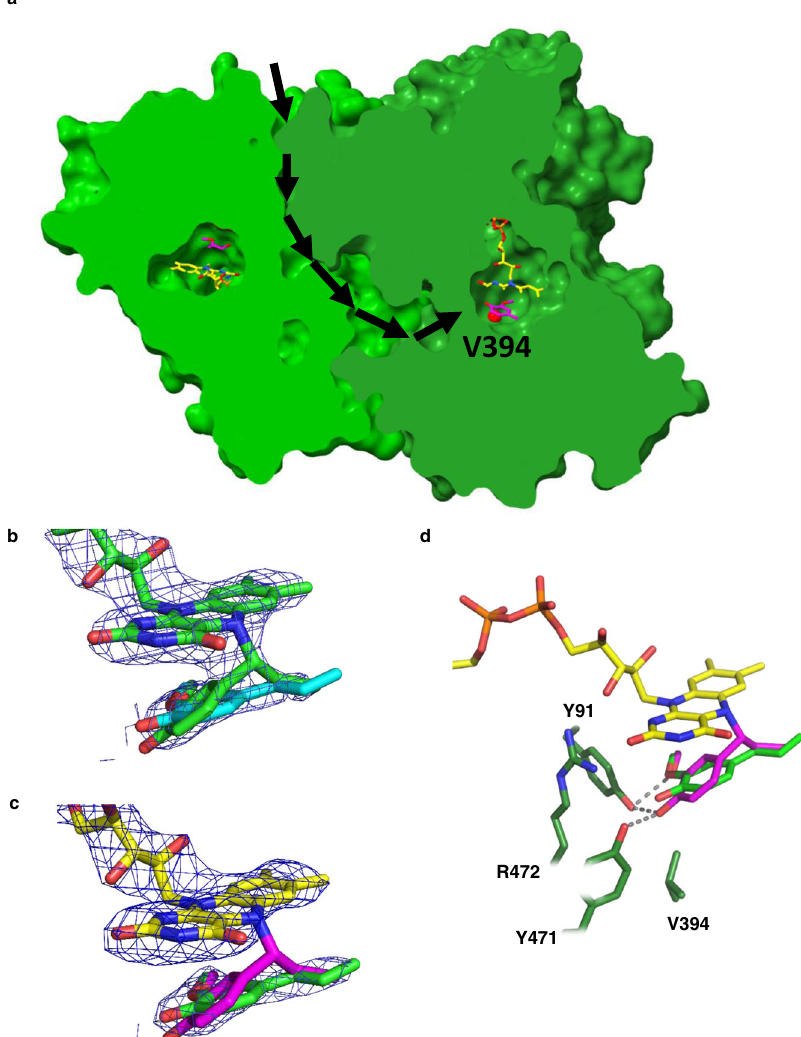
Fig. 5 | Structural features of S394V-EUGO5X. a Position of V394 in the cavity, showingaslicedviewofS394V-EUGO5X.ThemutatedV394,shownasaredsphere, is in close contact with a deep passageway buried between the two chains of the dimer. b , c Detailed views of the electron densitiesof4- n -propylguaiacol bound to twoS394V-EUGO5Xsubunits. b unbiased2Fo-Fcelectrondensitymapshowingthe presence of a stretch of electron density extending from the fl avin N5 atom and suggesting the presence of a covalent bond between the fl avin and 4- n -pro- pylguaiacol in subunit B. c unbiased 2Fo-Fc electron density map of a non- covalentlybound ligandobservedinchainA.Themapsarecontouredat1.2 σ level